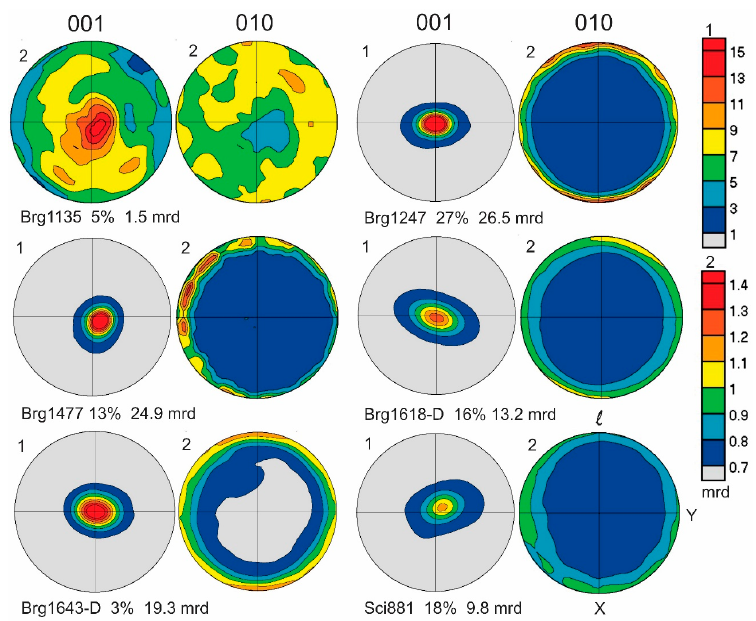
Figure 9. Neutron pole figures 001 and 010 of muscovite in Triassic quartzites. Equal area projection on the schistosity plane. Lineation is l . Numbers on top left of pole figures indicate the pole density scale that was used (in mrd). Next to the sample numbers are volume % and maximum of the 001 texture peak. D after sample number indicates Dubna neutron data.